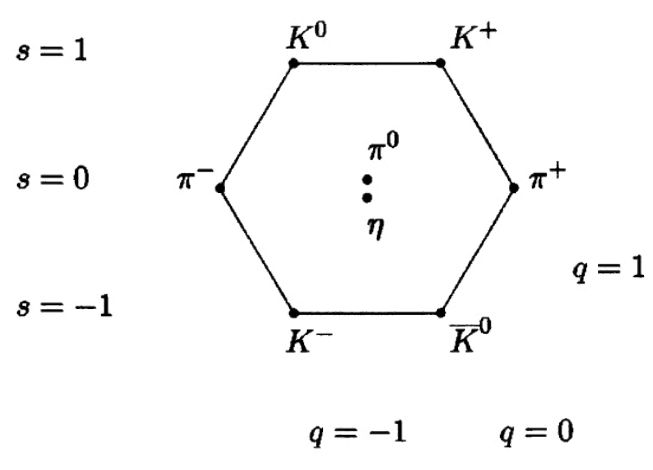
Figure 4: An illustration of the compatibility between the hadronic structure model of mesons, Eqs. (40)-(45), with physical constituents and the conventional SU (3) classi- fication. This compatibility is achieved via the identification of the isounits or isotopic elements per each meson, Eq. (46), and their use as the hyperunit of the ˜ SU (3) hyper- symmetry in view of its local isomorphism to the conventional